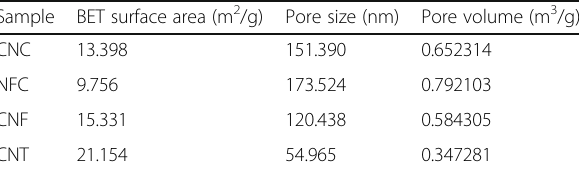
Table 2 BET results of natural and synthetics